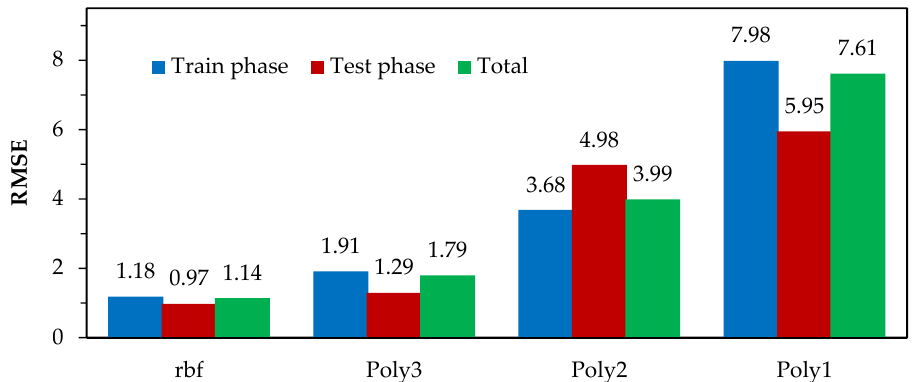
Figure 2. RMSE values for SVM model in three stages of learning, test, training, and total, using kernel functions of linear (Poly1), second-order (Poly2), third-order (Poly3), and base radial (RBF) for modelling the catalytic activity of the sample in the esterification reaction.